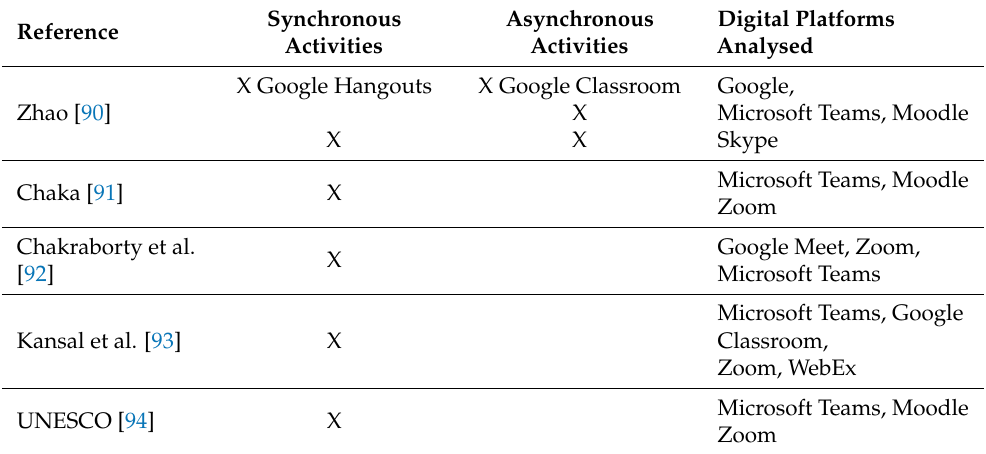
Table 5. Studies exploring digital platforms for synchronous and asynchronous